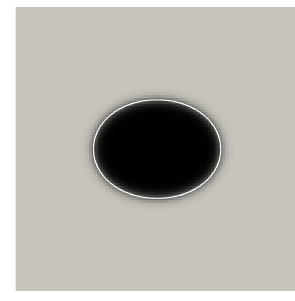
Figure 7. Problem 3.1: plots of E tot ( t ) obtained by scheme A for the main τ and τ = 0 and two time steps.